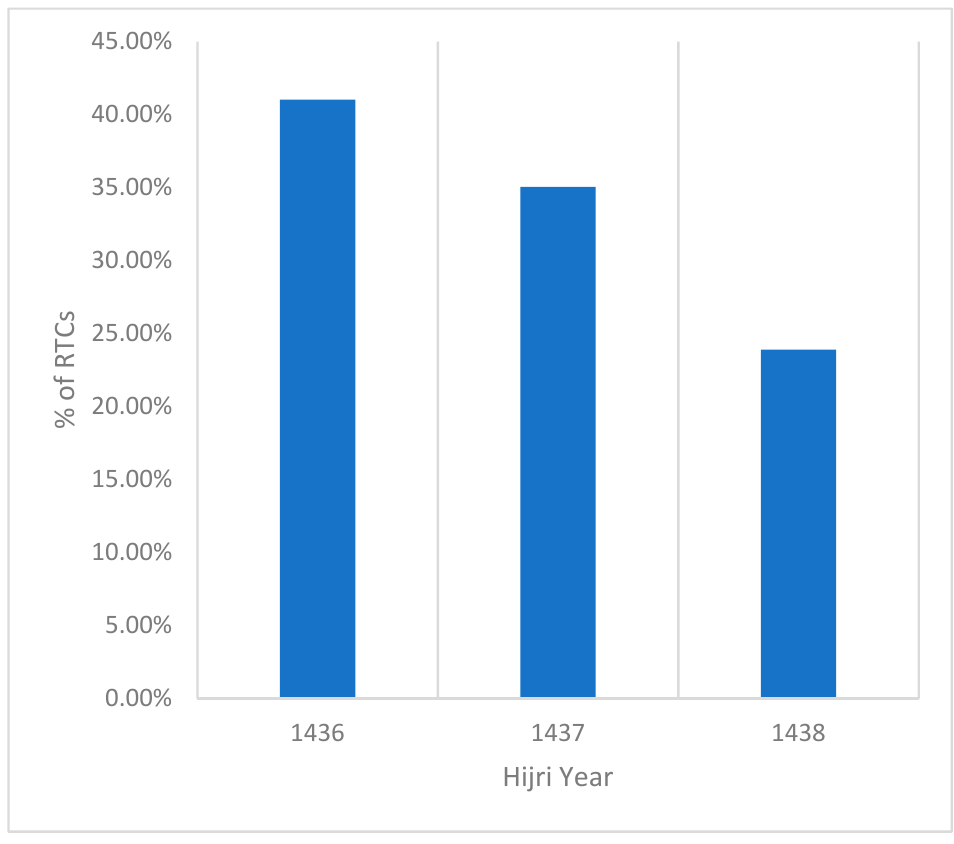
Figure 3. Chronological trend of fatal and serious injury traffic crashes.